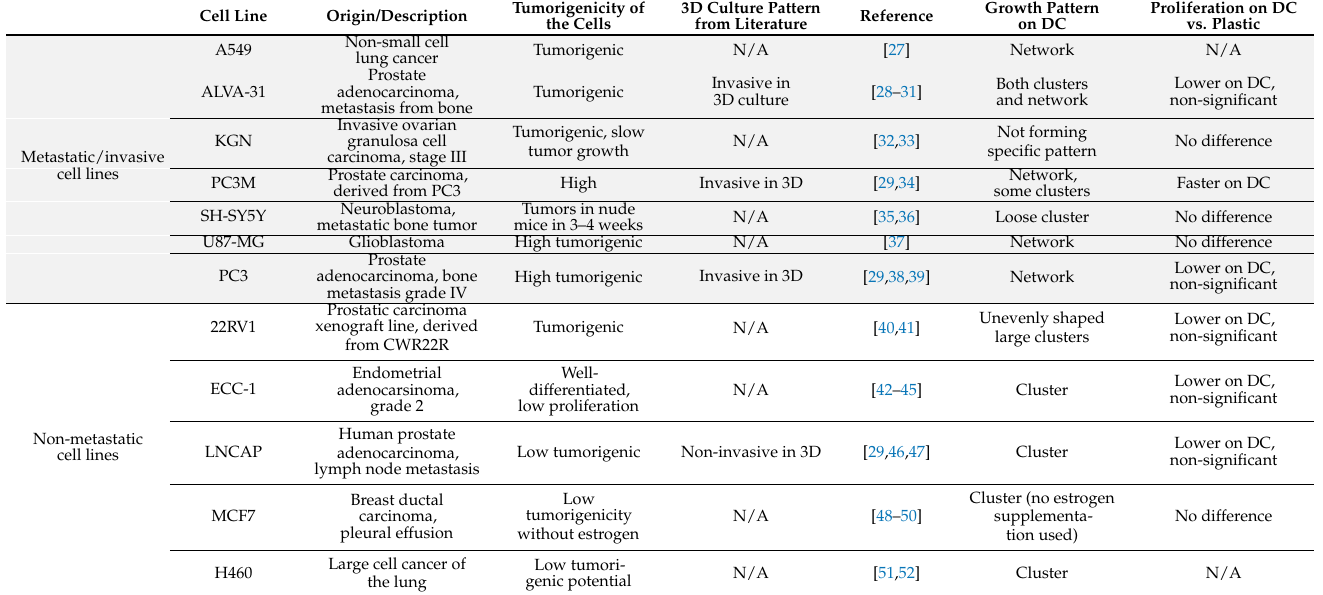
[40,41] Unevenly shaped large clusters Lower on DC,